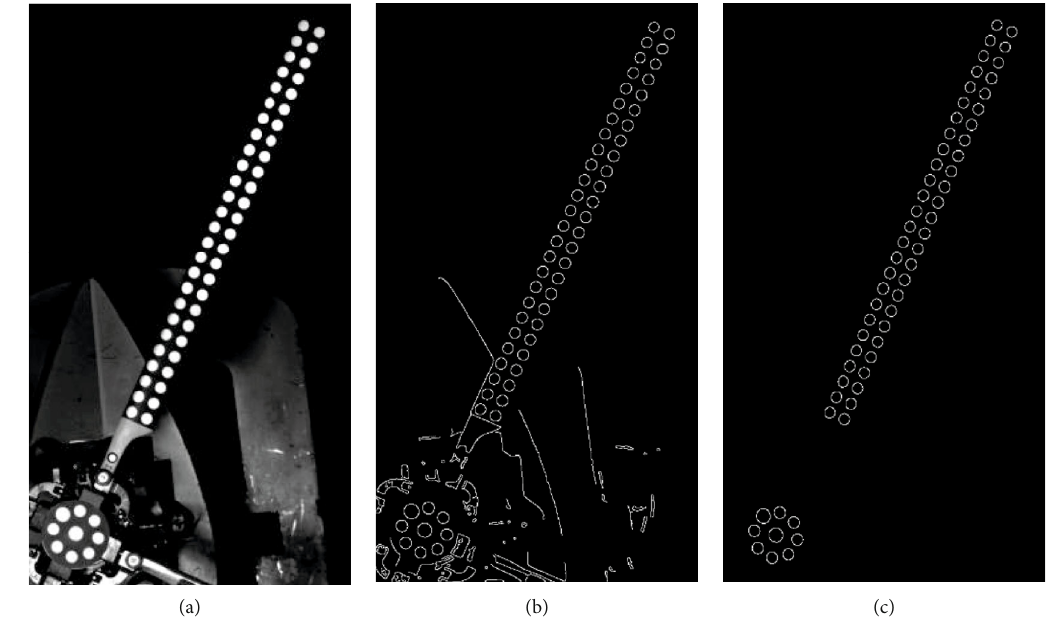
Figure 11: (a) The example image. (b) Image edge detection. (c) Target edge detection.